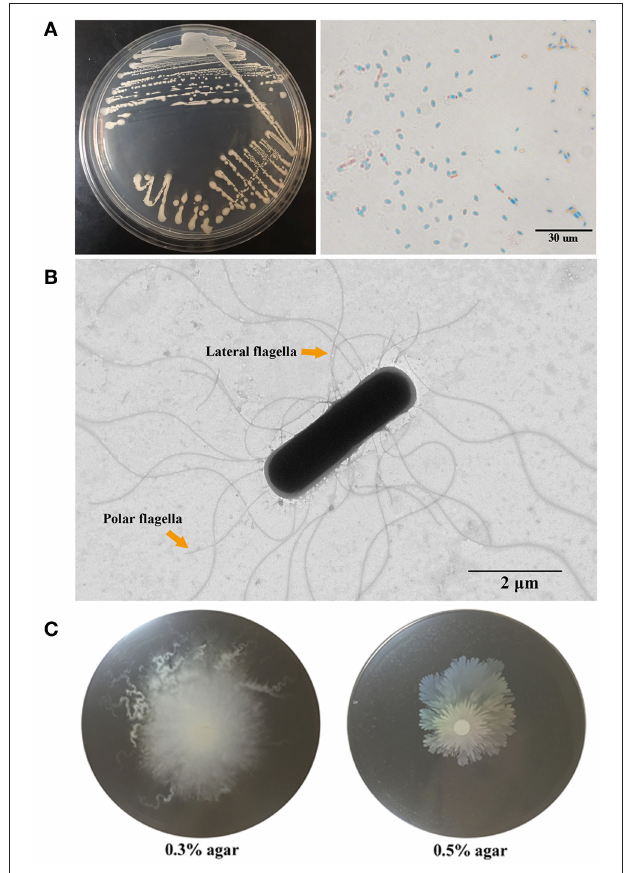
FIGURE 1 | Morphology and motility of G7. (A) G7 colonies on Marine 2216E plate (left) and micrograph of malachite green and safranine stained spores of G7 (right). (B) G7 was observed with a transmission electron microscope, the arrows indicate polar and lateral flagella. (C) G7 suspension was spotted onto the center of marine 2216E plates containing 0.3 or 0.5% (w/v) agar, and the plates were incubated at 28 ◦ C for 24